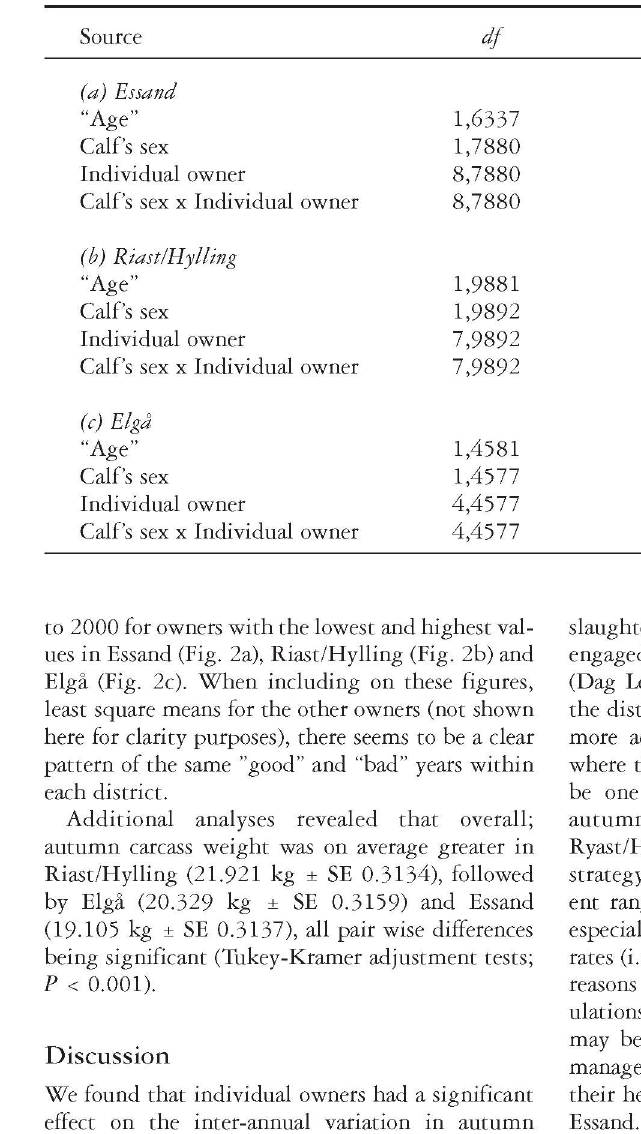
Table 2. Mixed model assessing the effects of calf sex, owner and year on calf autumn carcass weight in Essand (a), Riast/Hylling (b) and Elgå (c). Year was fitted as random factor in the three models. Interactions are denot ed by "x" between terms. We rejected terms with P value >